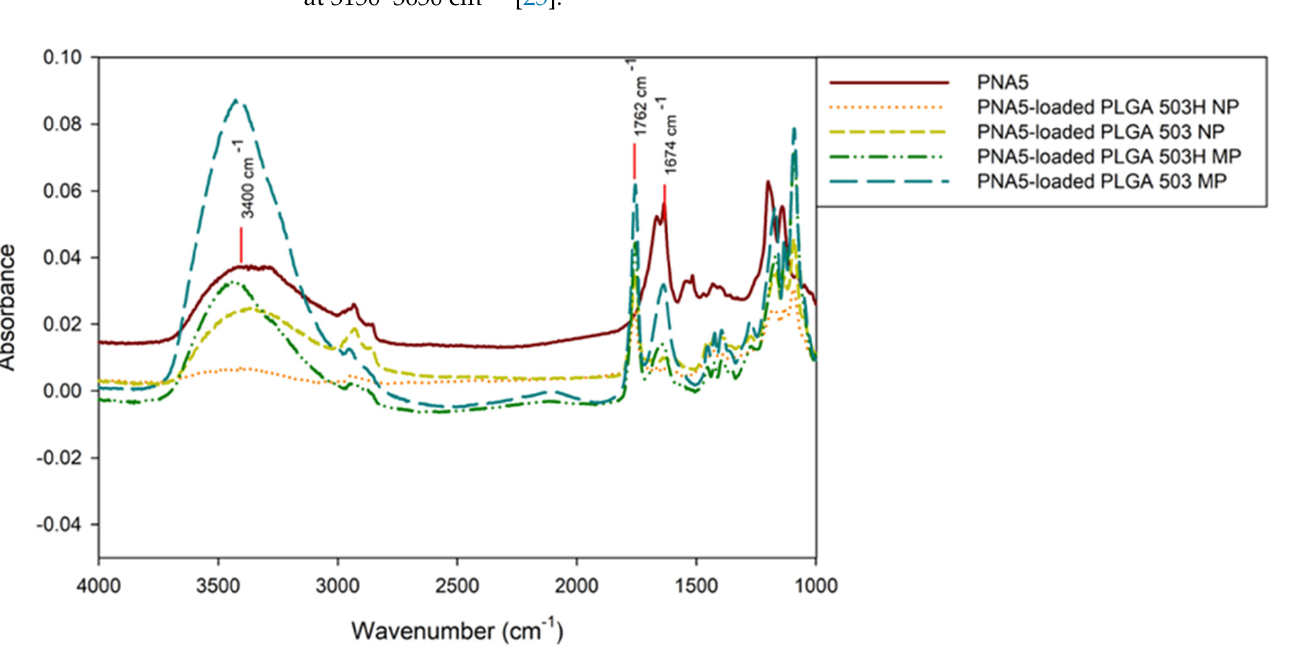
Figure 2. ATR FT-IR molecular fingerprinting spectra of Raw PNA5 glycopeptide and PNA5 PLGA polymeric nanoparticles and microparticles.